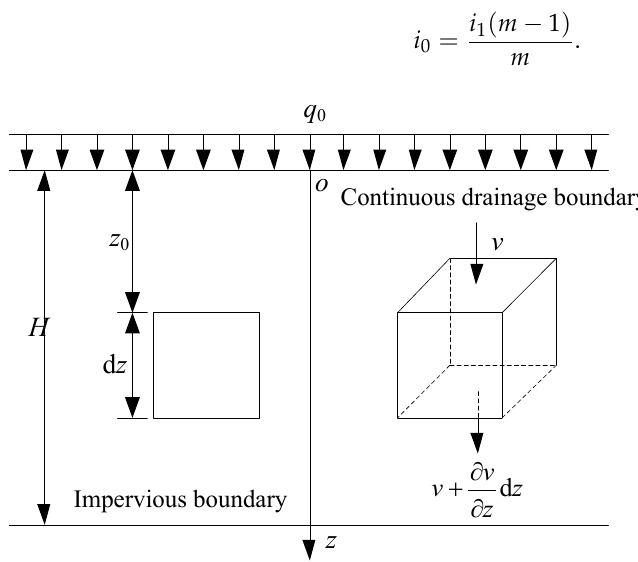
Figure 1. Schematic diagram of soft clay layer.